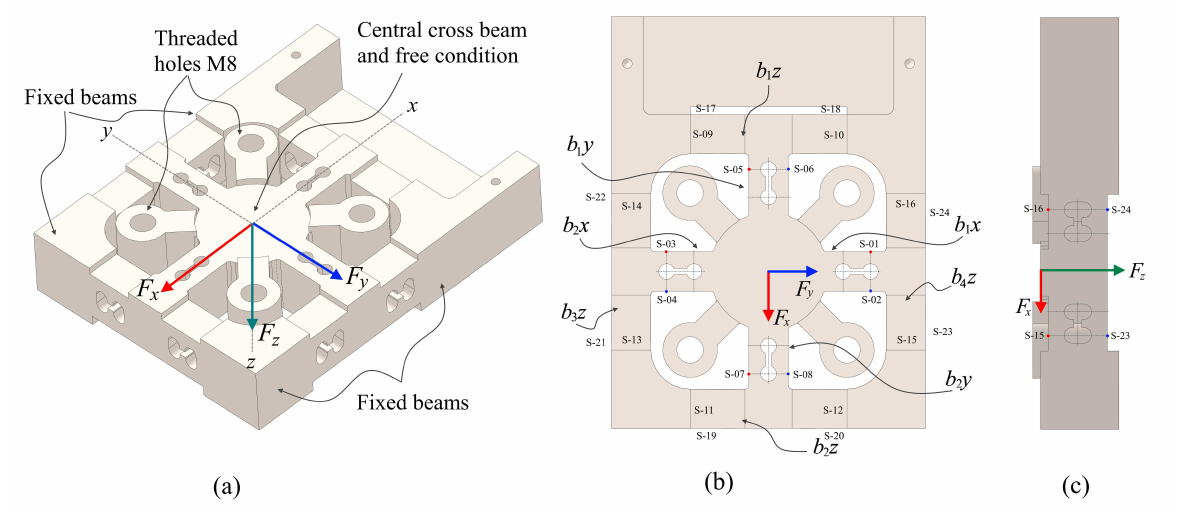
Figure 3. Structure of the cross-beam force transducer: ( a ) isometric view; ( b ) front view; ( c ) left side